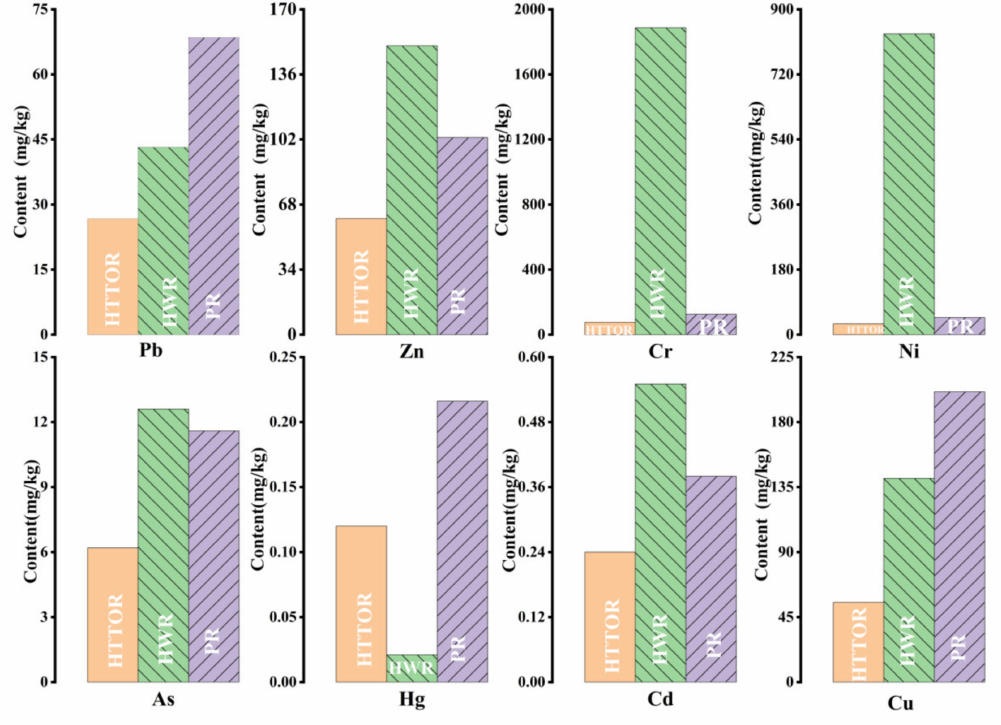
Figure 2. Heavy metal contents in the three types of heat treatment residues (HTTOR: high- temperature oxidation residue; PR: pyrolytic residue; HWR: thermal-washing